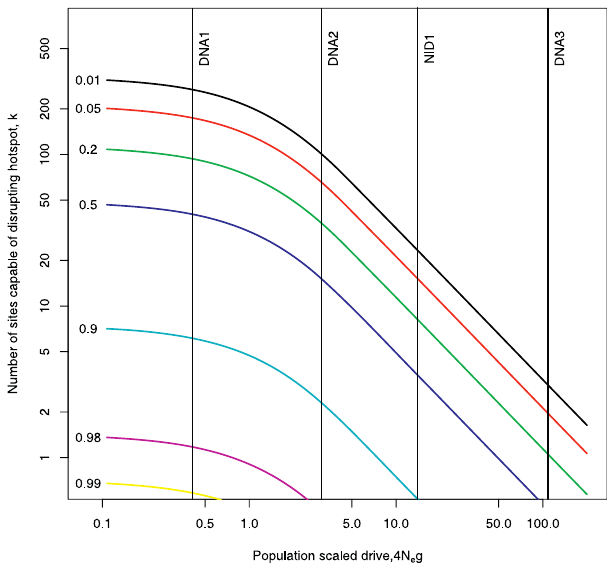
Figure 2. Probability That a Hotspot is Shared between Human and Chimpanzee Contour lines show the probability of sharing a hotspot between human and chimpanzee, as a function of the scaled drive 8 N e r H (1/2 (cid:2) p ) against the hotspot, and the number of sites capable of disrupting the hotspot, assuming effective population size N e ¼ 10,000. Each line refers to a different probability of sharing. The vertical lines correspond to our estimates of likely drive parameters for four known human hotspots, DNA1–3 and NID1. See text for further details.